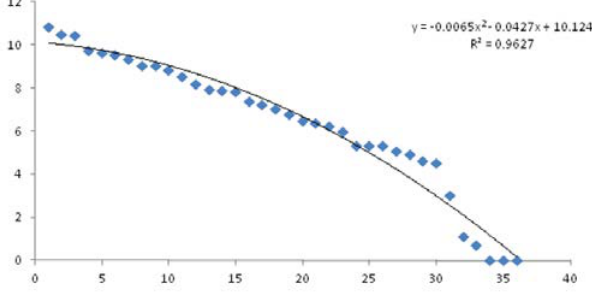
Fig. 7. Relative abundance of aquatic migrant birds. Data on X axis indicates species and on y axis individuals of corresponding species converted to natural log